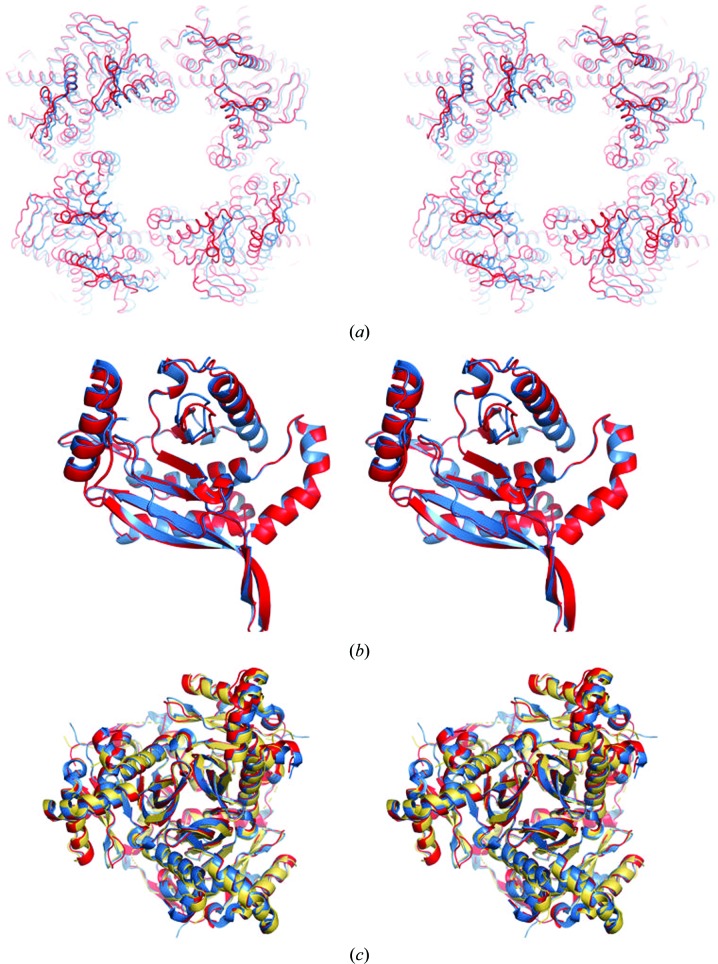
Structure and assembly of EcDSCD. (a) Superposition (stereo figure with depth cue) of the 24-mer biological assemblies of EcDSCD in the F432 (sky blue; PDB entry 1scz) and I4 (red; this work) crystal forms with respect to monomer A. For clarity, only the top 12-mer is shown as ribbons. The physiological significance of the observed structural changes is currently unknown, and these structural differences may arise from a different molecular packing under our crystallization conditions. (b) Stereoview of the superimposition of monomer A in the F432 (blue) and I4 (red) crystal forms. Significant structural changes are present in some loops; however, the overall structures are very similar (r.m.s.d. of 0.3 Å). The structural differences seen in the 24-mer superpositions arise from the differences in these loop-mediated intermolecular interactions, as well as the intermolecular rotational and translational changes. (c) Stereoview of the superposition of the trimers in P3121 (PDB entry 1c4t, yellow–orange), F432 (PDB entry 1scz, sky blue) and I4 (PDB entry 6pbr, red) crystal forms. Some conformational changes exist in helices and loop areas.